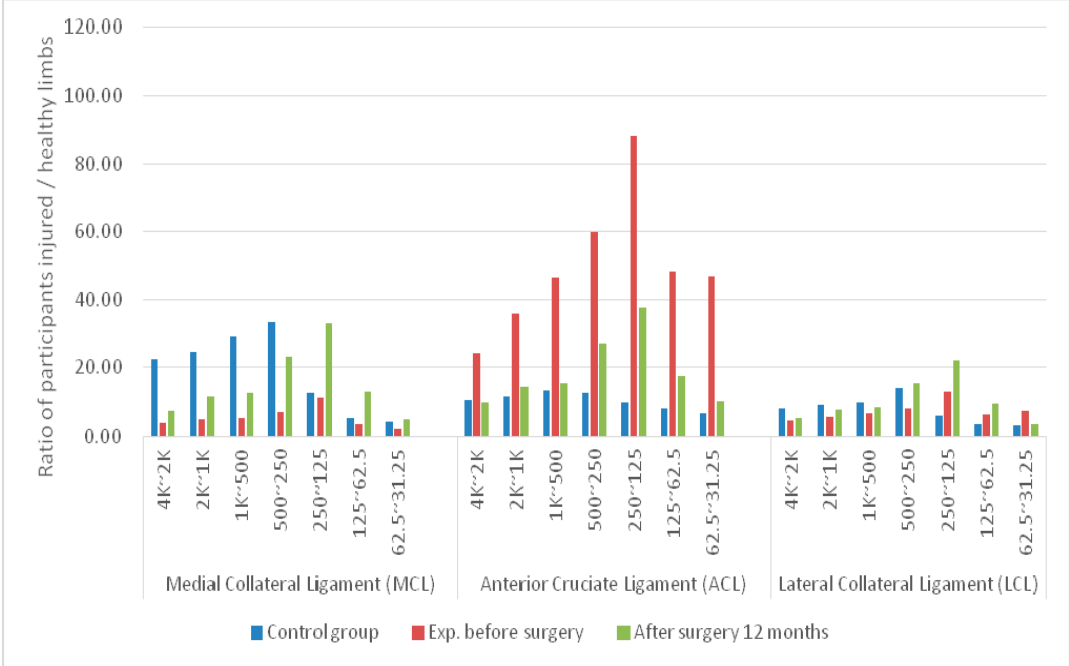
Figure 6. Average differences in signal bands at the MCL, ACL, and LCL sensing points of two limbs between control and experimental groups before surgery and 1 year after surgery.